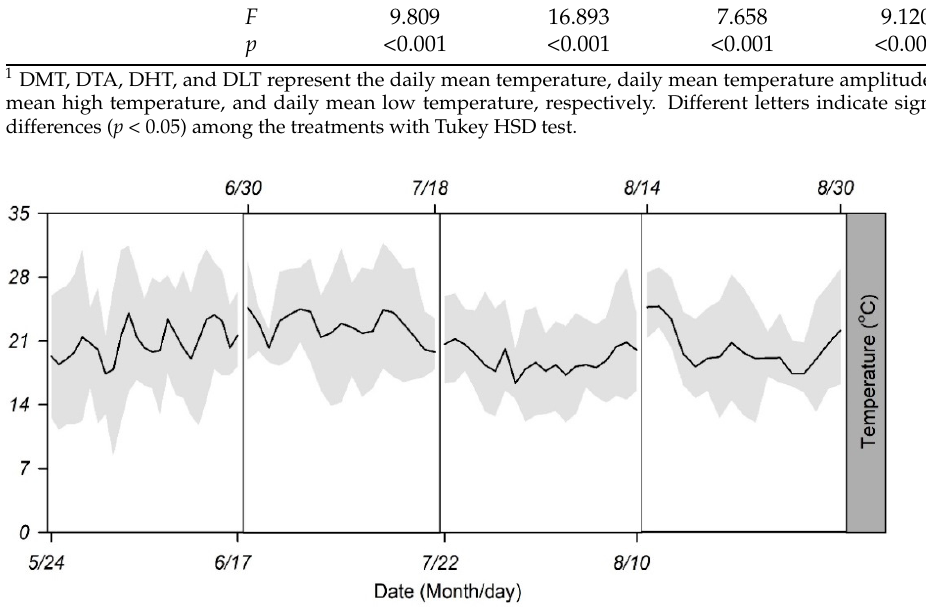
Figure 1. Daily mean temperature (DMT) (solid black line) and daily mean temperature amplitude (DTA) (grey area) experienced by cruciferous vegetable species grown in fields from 24 May to 30 August 2011 in Fanshi County, Shanxi Province, China.